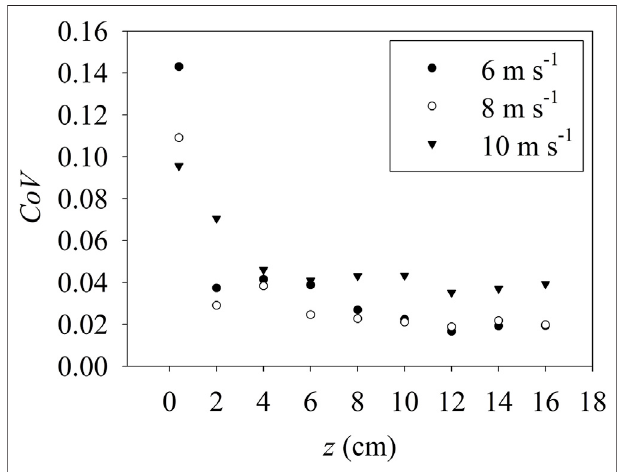
Frontiers in Earth Science |